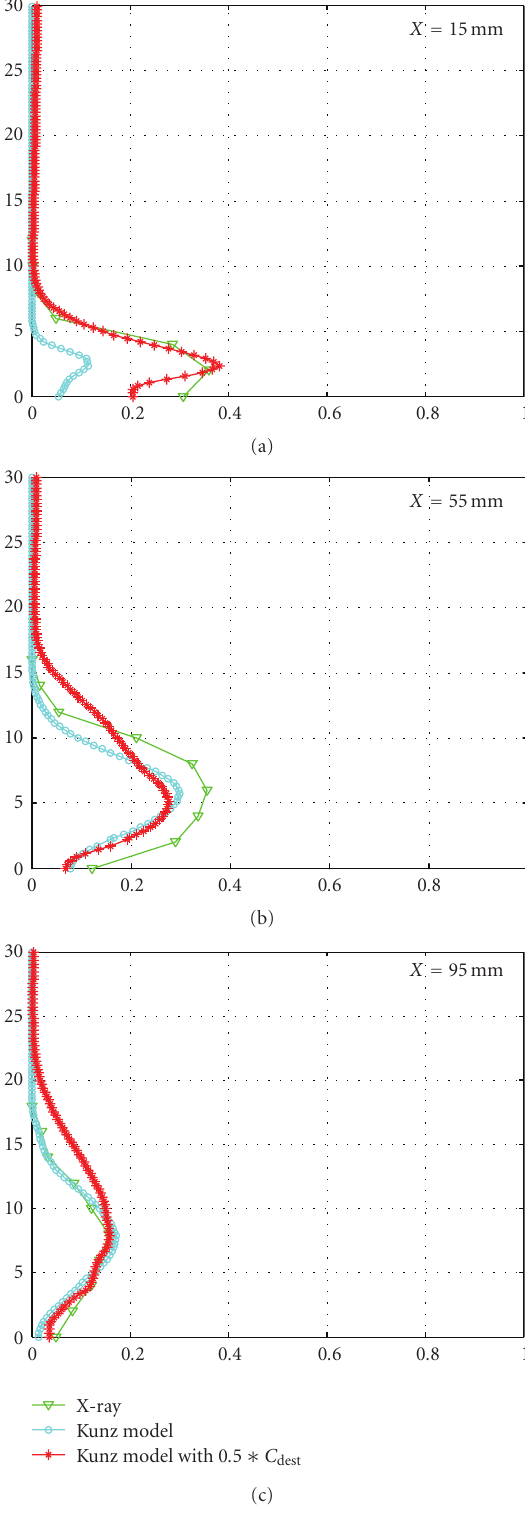
downstream and finally collapses, while the residual cavity starts to grow again.